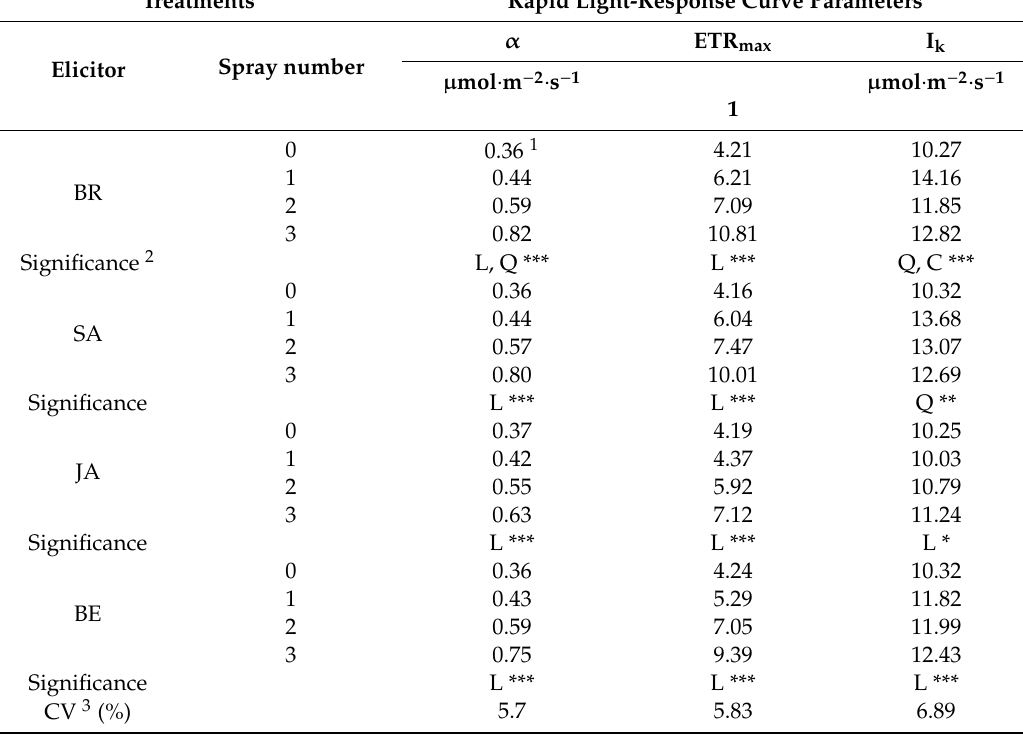
Table 1. E ff ect of the interaction between synthetic elicitors (Salicylic acid (SA), jasmonic acid (JA), Brassinosteroids (BR), or botanical extracts (BE)) and the sprays number (0, 1, 2 and 3 applications) on the rapid light-response curve parameters (initial slope of the curve ( α ), maximum electron transport rate (ETR max ) and minimum saturation irradiance (I k )) in Fusarium oxysporum f. sp. physali infected cape gooseberry ( Physalis peruviana L.) plants at 50 DAI. Treatments Rapid Light-Response Curve